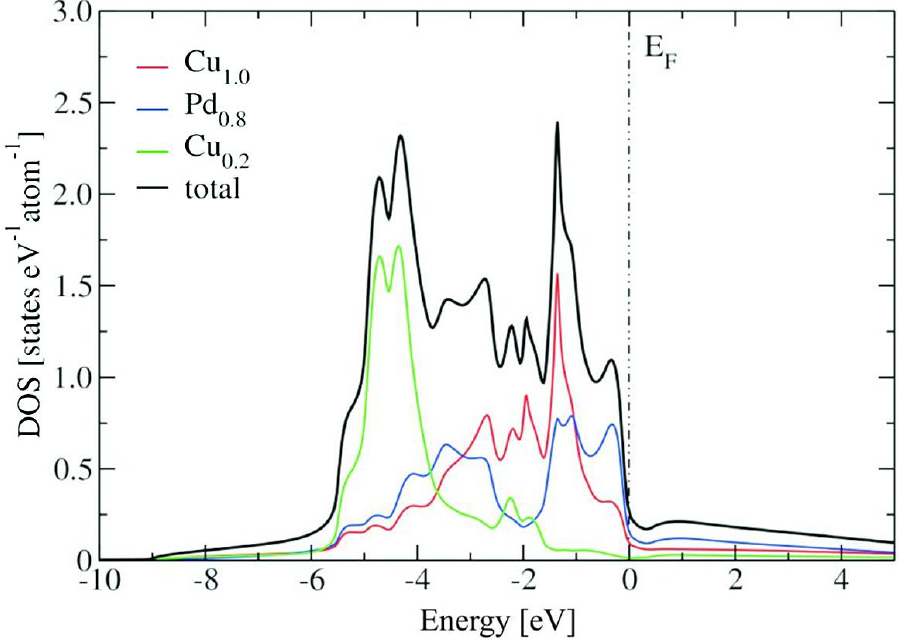
Figure 4. Total density of states (DOS) of the ordered Cu set to zero). Partial atomic contributions are also